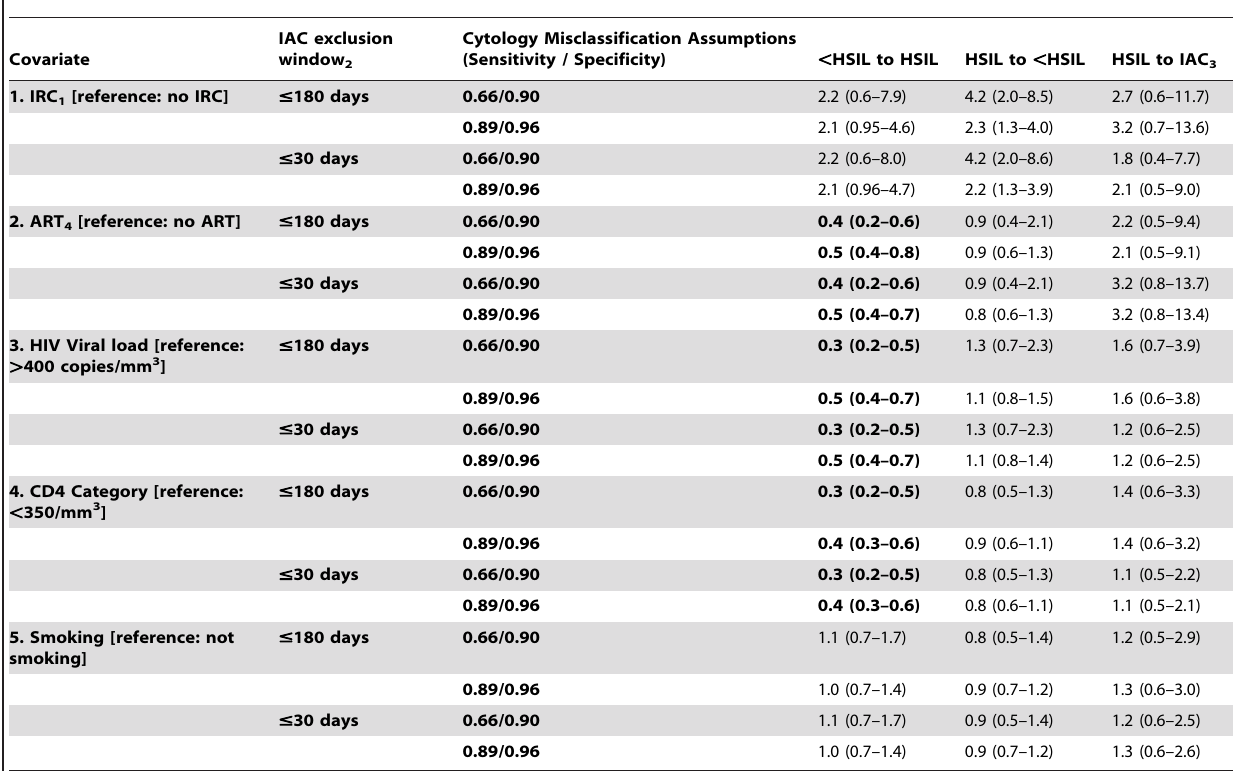
Table 4. Estimated Unadjusted Hazard Ratios (95% CI) of Time-Updated Covariate Effects on State Transitions, by Misclassification Assumptions and by IAC-Exclusion Window ( # 180 vs. # 30